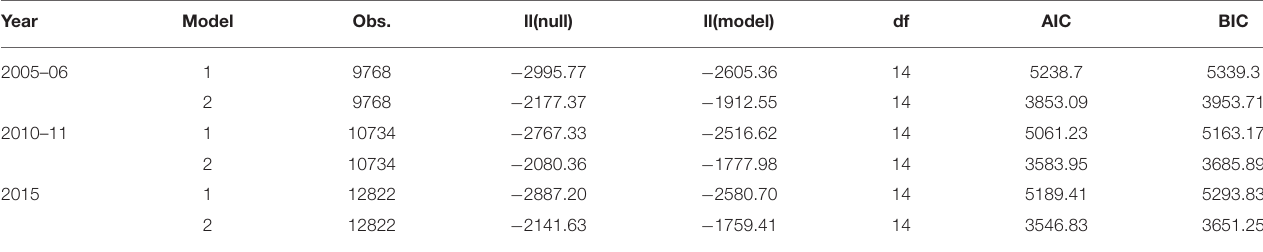
TABLE 2 | Akaike information criterion and bayesian information criterion